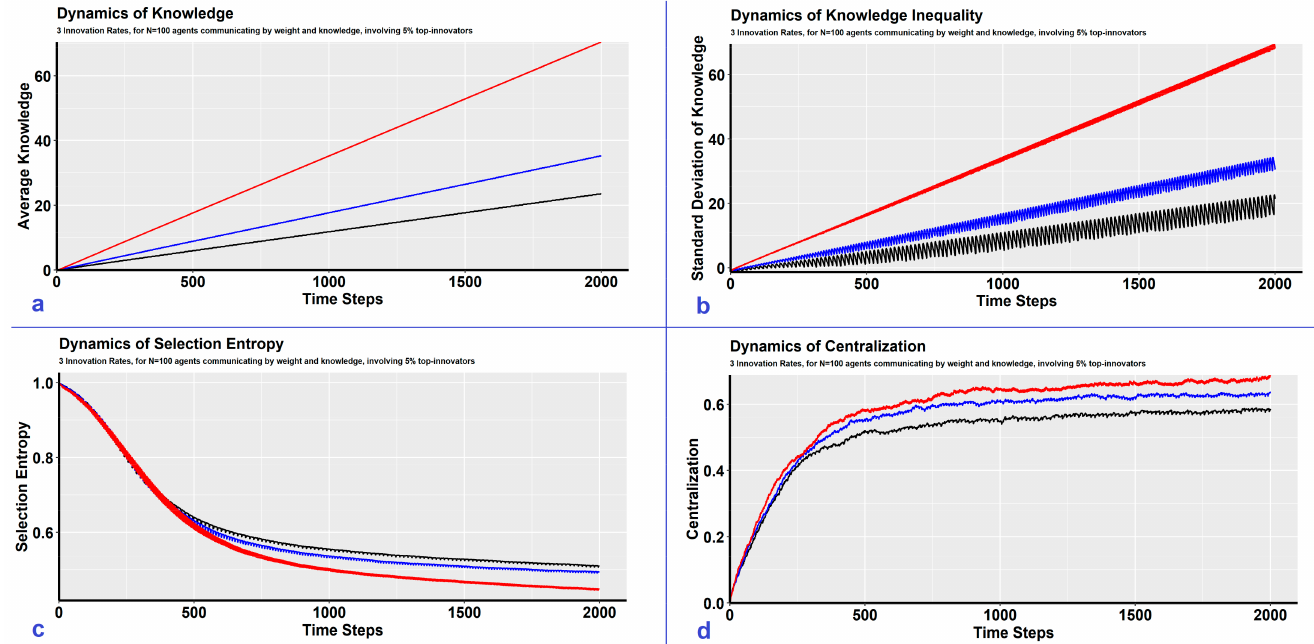
Figure 3. Simulations for the 3 different innovation rates: (1) low rate with period 𝑇 = 15 steps (black), (2) medium rate with period 𝑇 = 10 steps (blue), (3) high rate with period 𝑇 = 5 steps (red). Results are illustrated for: ( a ) the average knowledge (Definition 8, up left), ( b ) the standard deviation of knowledge (Definition 9, up right), ( c ) the selection entropy (Definition 10, down left), ( d ) the centralization (Definition 13, down right). The y axis for the average knowledge ( a , up left) and the standard deviation of knowledge ( b , up right) is in log‑10 scale, indicating the exponential increase of knowledge dynamics. Results are illustrated for 𝑁 = 100 agents communicating by weight and knowledge ( s = 𝓌𝓀 ), involving 5%